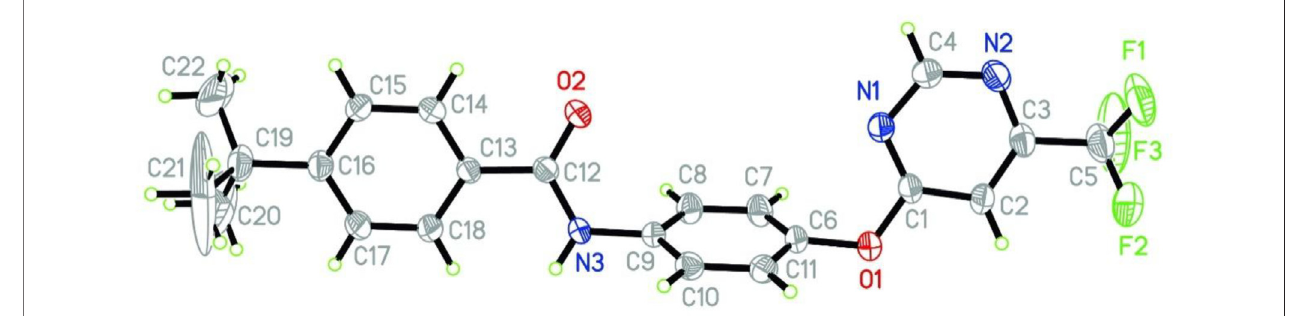
FIGURE 2 | X-ray crystal structure of 5p